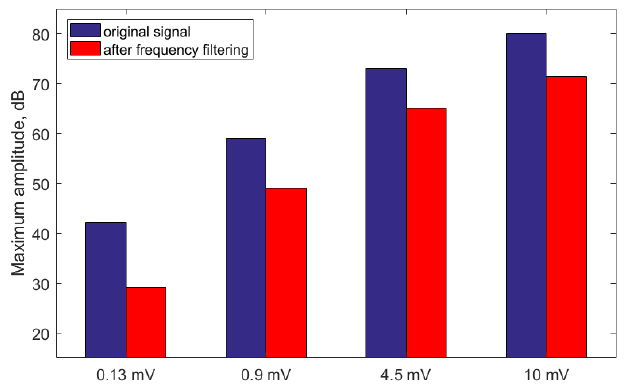
Figure 9. Changes in the maximum amplitude of the Type 3 acoustic signal at different levels of its intensity.